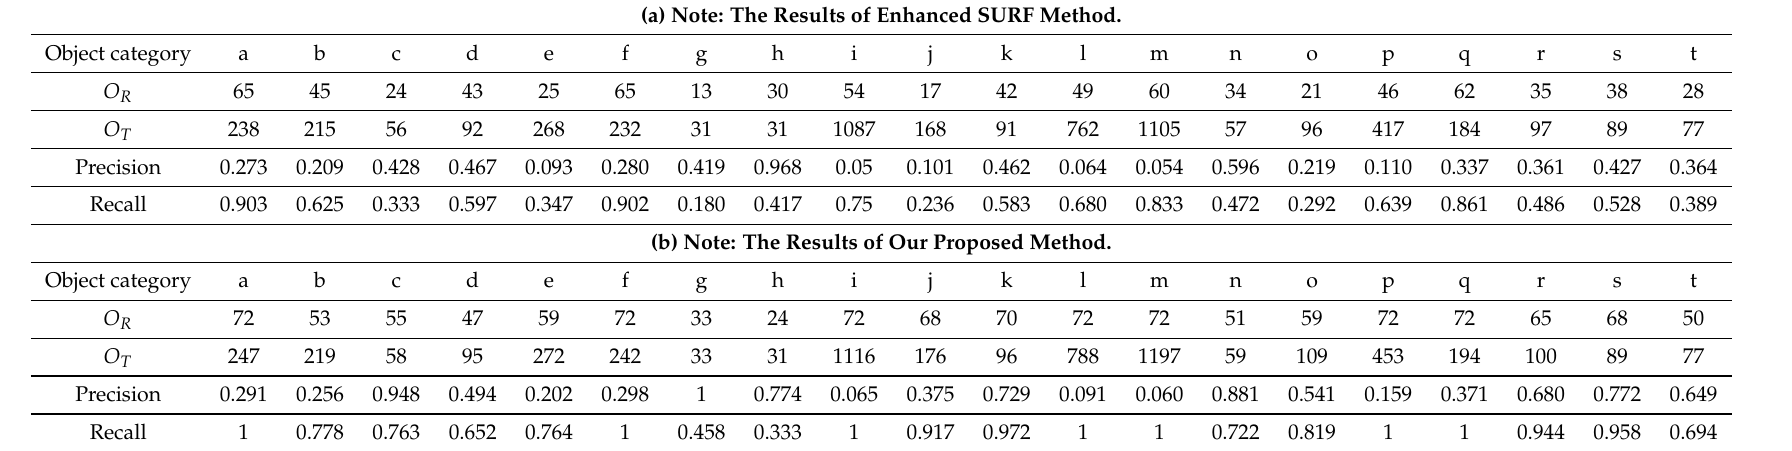
Table 1. Comparisons of precision and recall results among enhanced SURF method and our Proposed